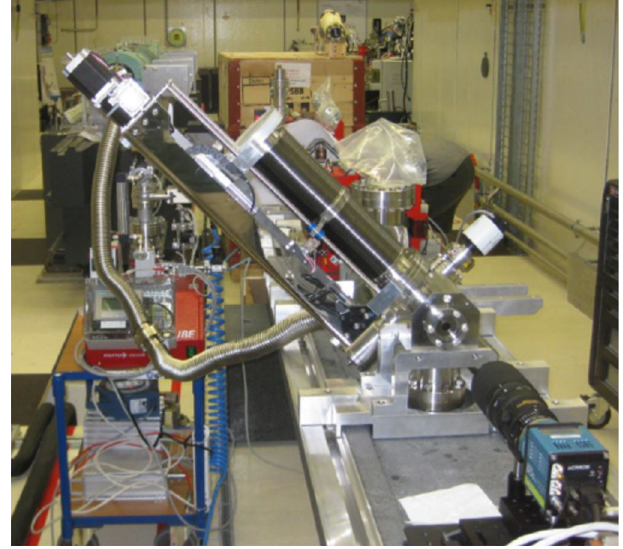
FIG. 3. Image of a prototype of the SwissFEL WSC installed onto a girder together with the measurement setup of the stepper- motor induced vibrations of the